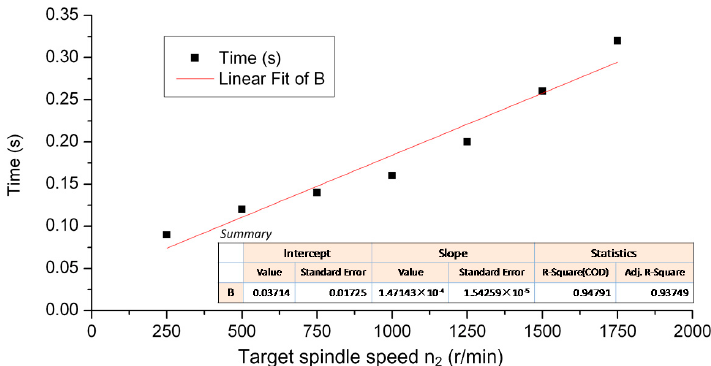
Figure 12. Linear fitting between t SR 2 and n 2 .